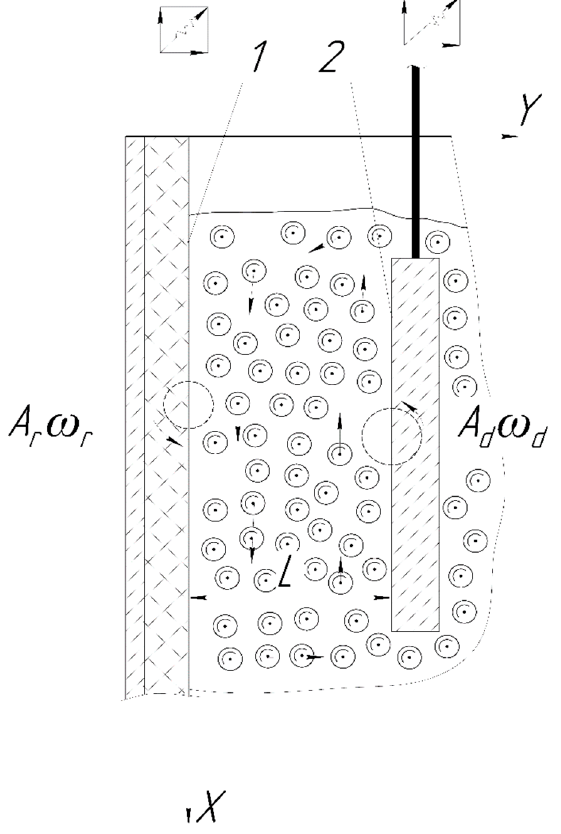
Figure 1. Oscillating surfaces filled with pseudo-gas from the abrasive granules.